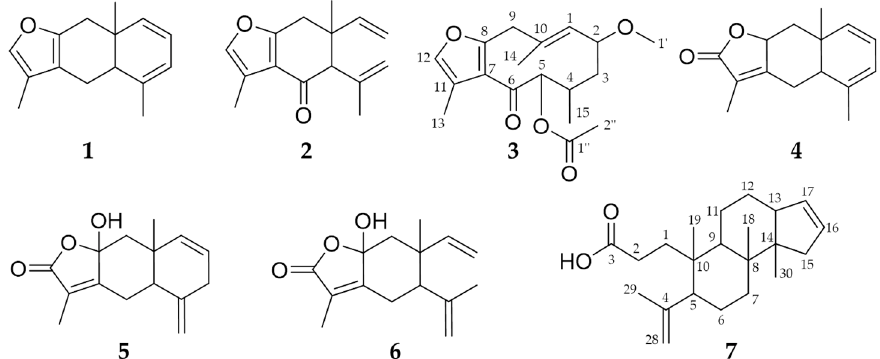
Figure 1. Chemical structures of the compounds identified in the myrrh extract: furanoeudesma-1,3- diene ( 1 ), curzerenone ( 2 ), 2-methoxy-5-acetoxyfuranogermacr-1(10)-en-6-one ( 3 ), 5- α H,8- β H-eudesma-1,3,7(11)-trien-8,12-olide ( 4 ), hydroxylindestrenolide ( 5 ), hydroxyisogermafurenolide ( 6 ) and 3,4-secomansumbinoic acid ( 7 ).